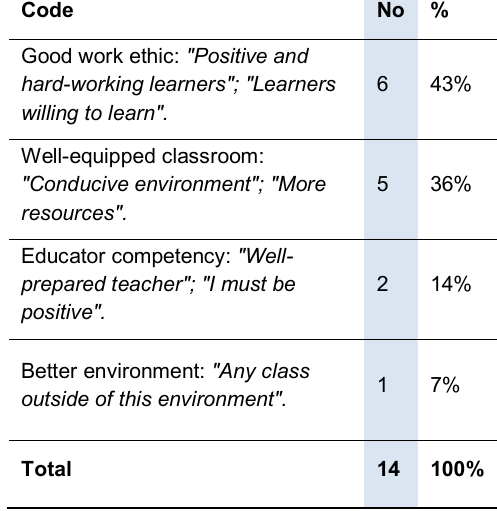
Table 1: Coding frame – Competent Classroom, Pre- TA